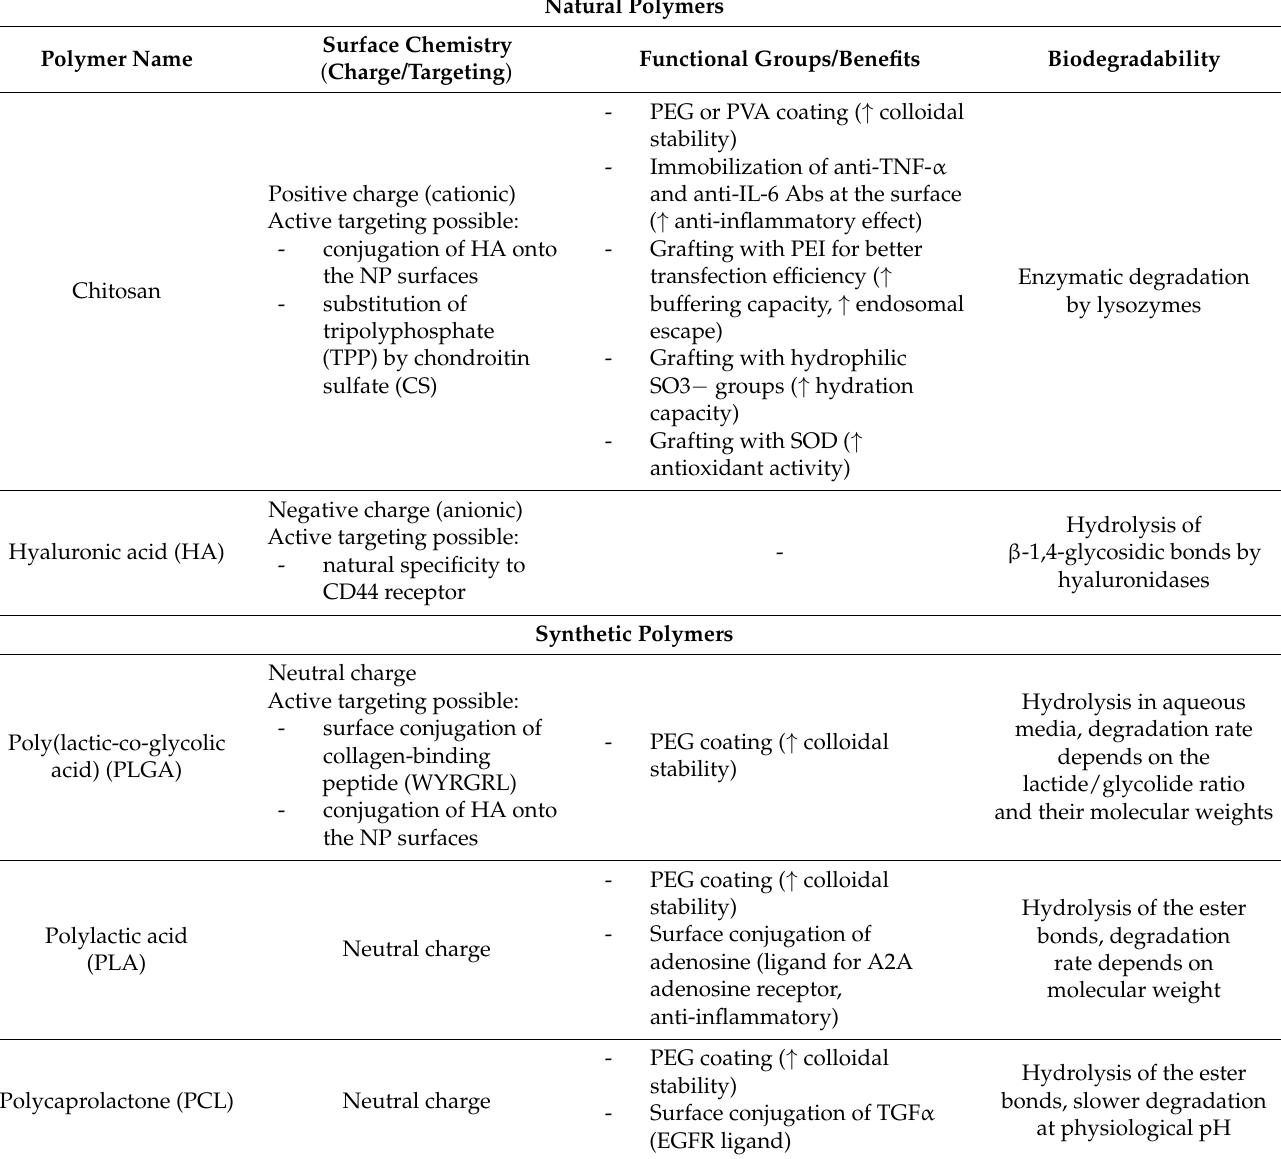
Table 2. Physicochemical properties of the most common polymeric nanoparticles tested for drug delivery in OA treatment. Functional groups listed according to evidence from these